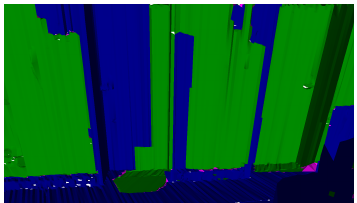
Figure 10. An example of mesh fusion on triangle quality. In (a) and (b), triangles in red rectangles are elongated. In (c), the left mesh is in , and right mesh is in .